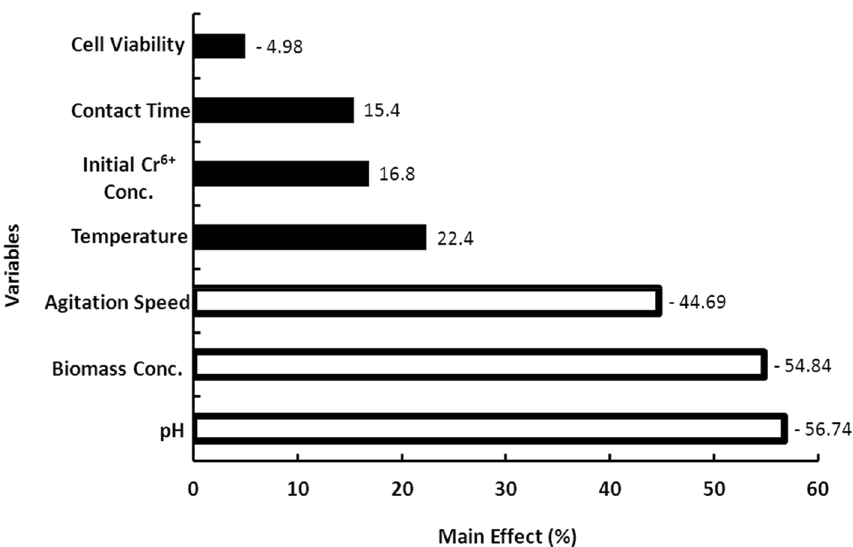
Figure 5. Pareto chart representing the percentage main effects of the different independent variables affecting the biosorption of Cr(VI) by S. rochei ANH using PBD. The white bars represent the significant variables, while the black bars represent the insignificant